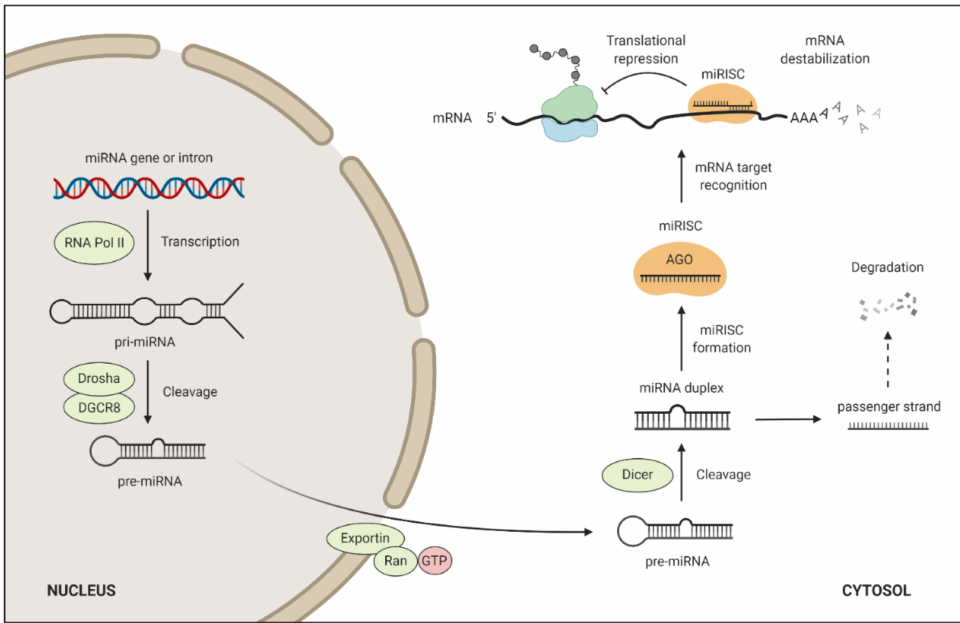
Figure 2. miRNA biogenesis and target regulation. miRNA biogenesis pathway begins with the transcription of a much larger primary miRNA transcript (pri-miRNA). The pri-miRNA is processed into a smaller pre-miRNA by the endonuclease Drosha and subsequently transported out of the nucleus through Exportin-5. In the cytosol, the pre-miRNA encounters the endonuclease Dicer, which cleaves off the hairpin loop, leaving a pre-miRNA duplex. One of the strands, constituting the mature ~22 bp miRNA, then associates with an Argonaut protein to form the miRNA-induced silencing complex (miRISC). Once bound to the targeted mRNA, miRISC induces translational repression and mRNA destabilization, thereby downregulating gene